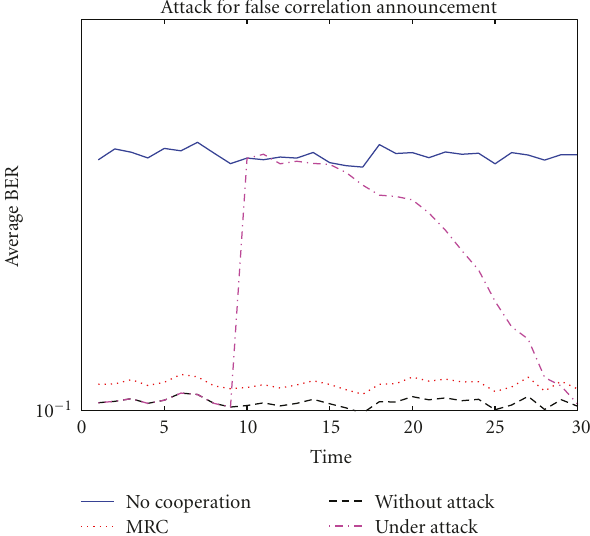
Figure 10: Bad-mouthing attack and self-healing. same as that of no jammer case. However, if the jammer is very close to the destination, the proposed scheme can only improve the performance